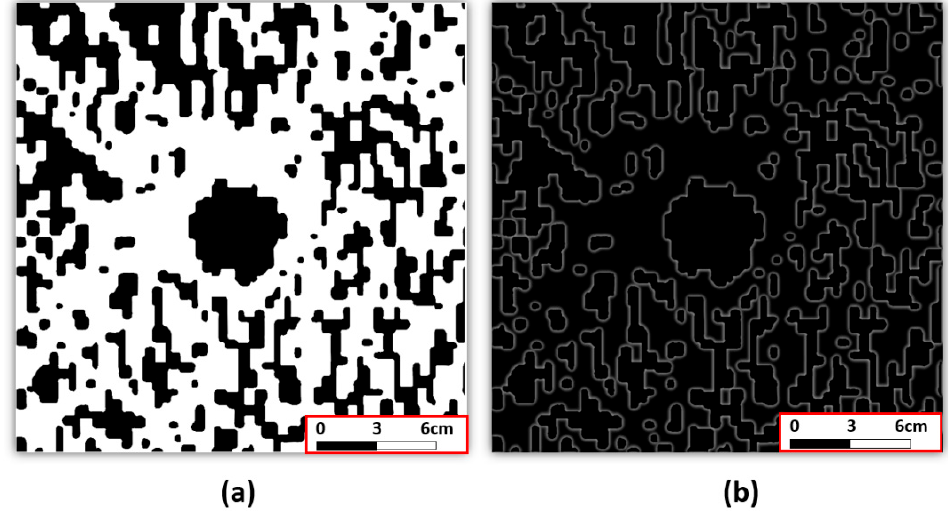
Figure 6. Retrieval of DBH from raw VDT measurement data: ( a ) a raw VDT measurement outcome of a cross-section of trees; ( b ) the line of perimeter and DBH were extracted using image segmenta- tion.